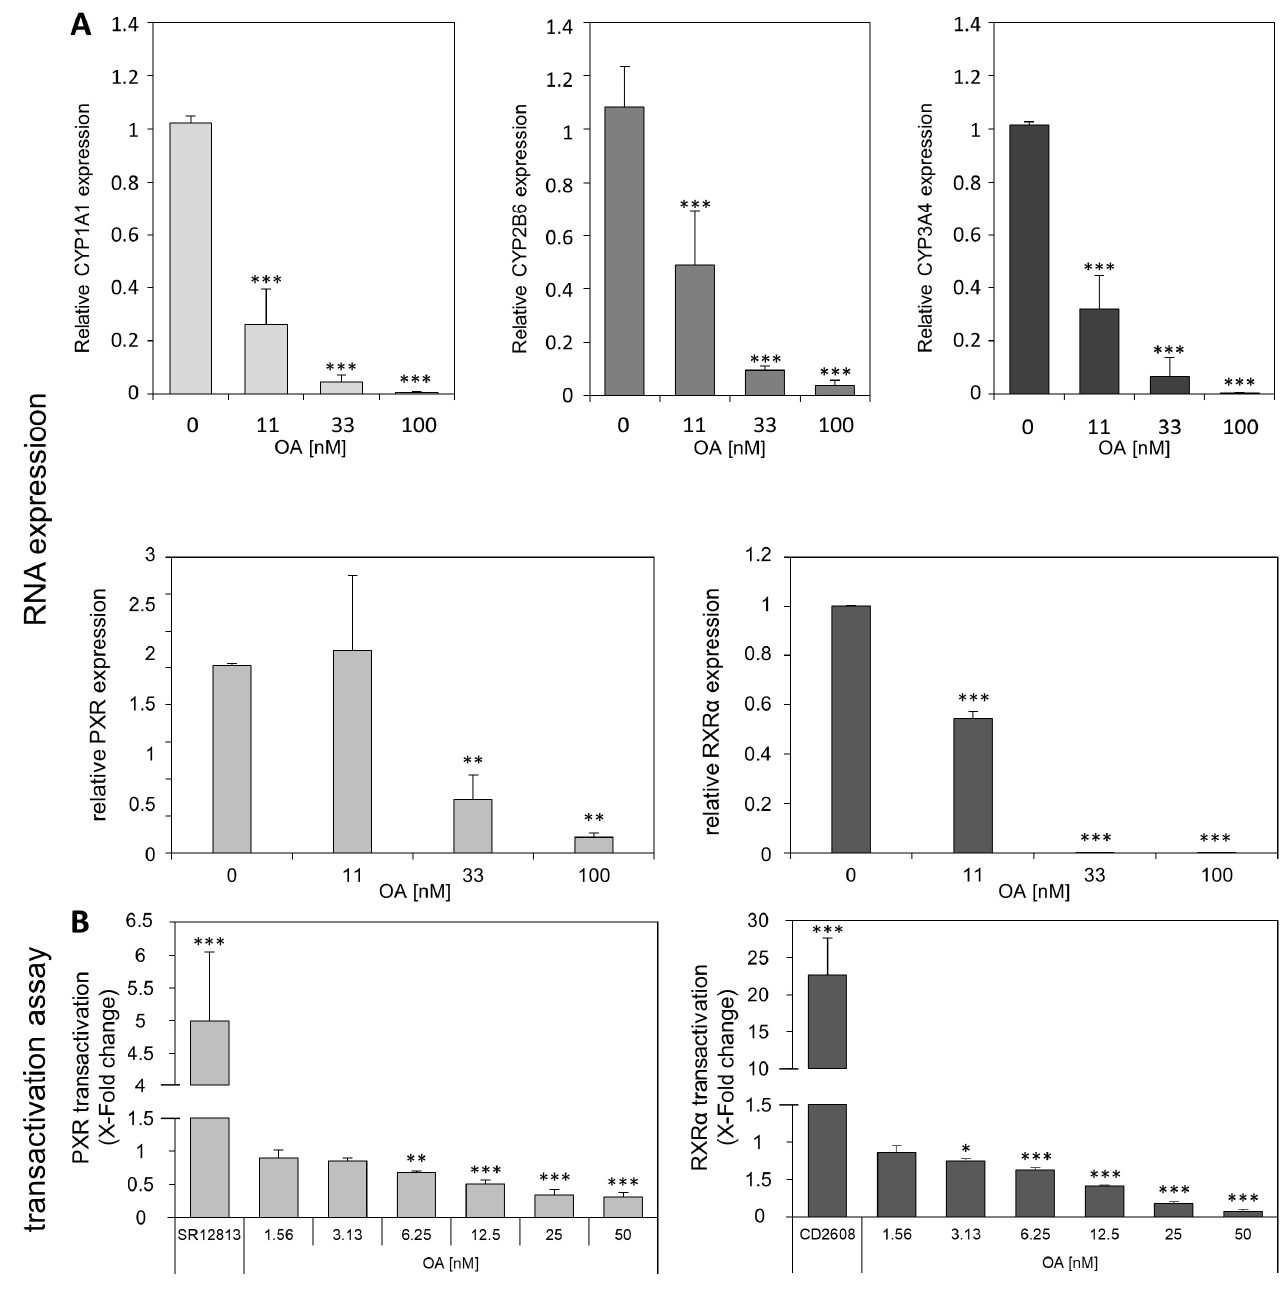
Figure 2. Relative expression of CYP1A1, CYP2B6 and CYP3A4, PXR, and RXRα. ( A ): Differentiated HepaRG cells were treated with 11, 33, and 100 nM OA or with the respective solvent control for 24 h. Analysis of RNA levels of CYP1A1, CYP2B6, CYP3A4, PXR, and RXR α in HepaRG cells after exposure to OA was performed by qPCR. The bar charts show the resulting fold changes as mean of three independent replicates, relative to the solvent control. ( B ): Transactivation of PXR and RXR α in HEK-T cells. The cells were transfected with plasmids before incubation with OA for 24 h. SR12813 (10 µ M) and CD2608 (100 nM) were used as positive controls. The cytotoxicity assay in HEK-T cells relevant for the chosen OA concentrations for the transactivation assay can be found in Figure S1. The bar charts show the resulting fold changes as mean of three independent replicates, relative to the solvent control. Statistical analysis for all charts (n = 3) was performed using one-way ANOVA followed by Dunnett’s post-hoc test (* p < 0.05; ** p < 0.01; *** p <